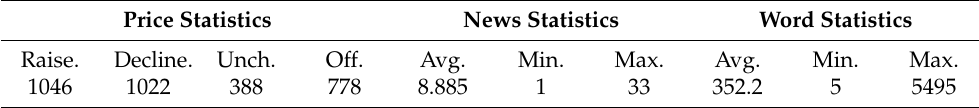
Table 1. Statistical information from Henry Hub natural gas price and WorilOil news text.